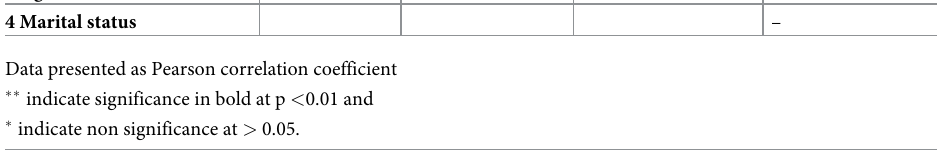
Data presented as Pearson correlation coefficient �� indicate significance in bold at p < 0.01 and � indicate non significance at >